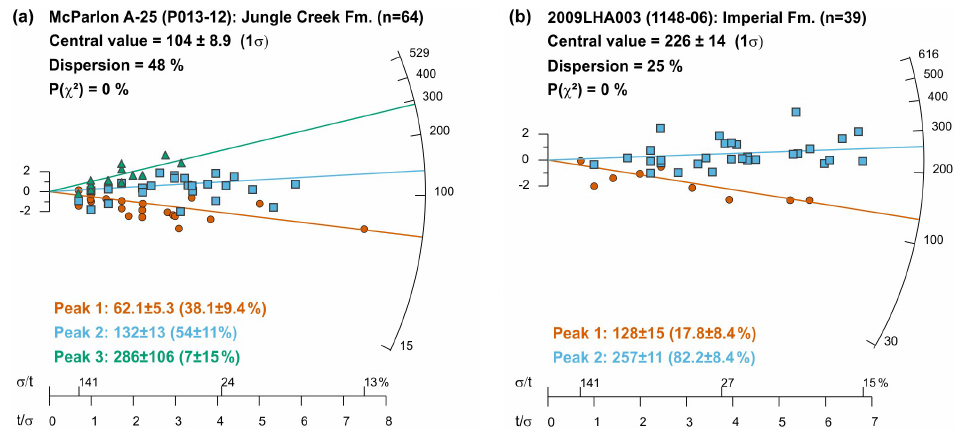
Figure 3. Radial plots of single-grain ages for the multikinetic Permian (a) and Devonian (b) AFT samples. Points are colour coded according to the kinetic populations determined in Figs. 4 and 5. Peak ages are from age mixture modelling (estimated percentage of grains per population in brackets) and show good correspondence with kinetic population ages summarized in Table